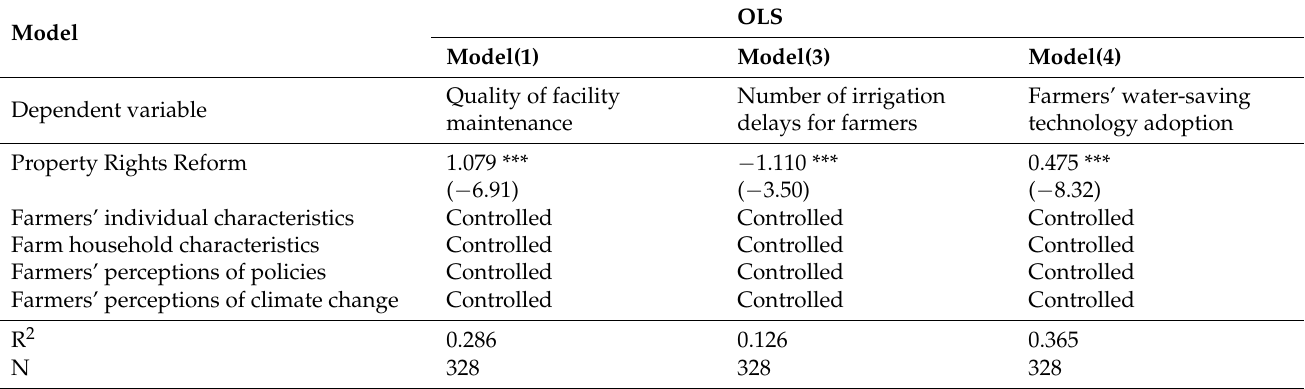
Table 9. Regression results of robustness analysis of the effect of property rights reform of agricultural water facilities on the quality of facility maintenance and water-saving technology adoption